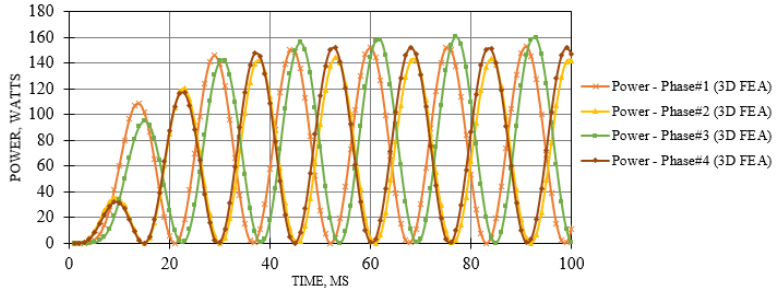
Figure 18. 3D-FEA instantaneous power output of the TFM alternator at 400 rpm—Ideal case.